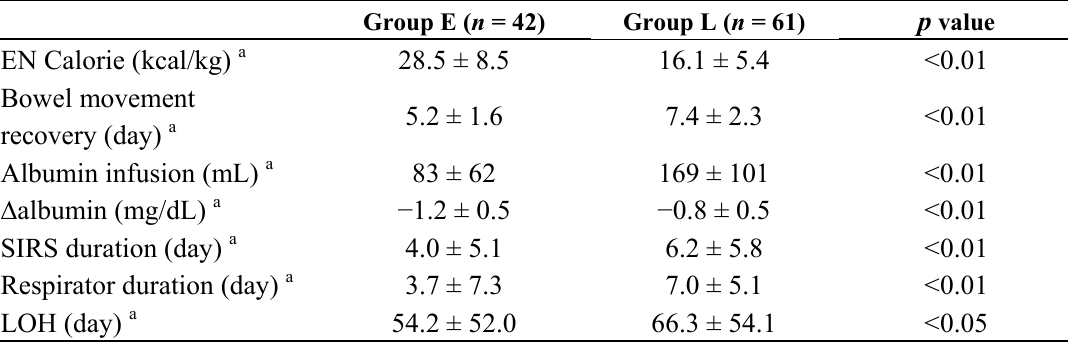
Table 3. Postoperative outcomes: Early versus Late EN ( n =